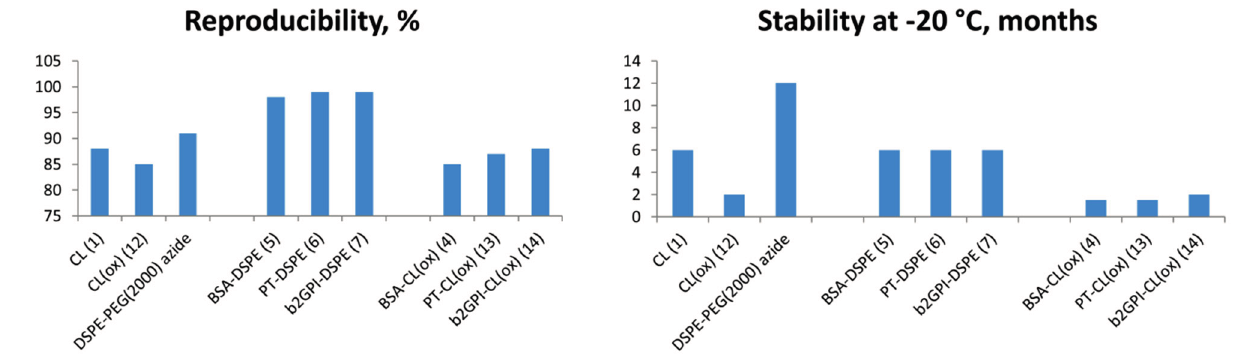
Figure 3. Comparative performance of phospholipid antigens in ELISA detection of autoimmune Abs. The reproducibility assay was performed independently three times over 6 week time period using controls: a-PL, a- β 2GPI, a-ssDNA, a-dsDNA and HNP ( n =